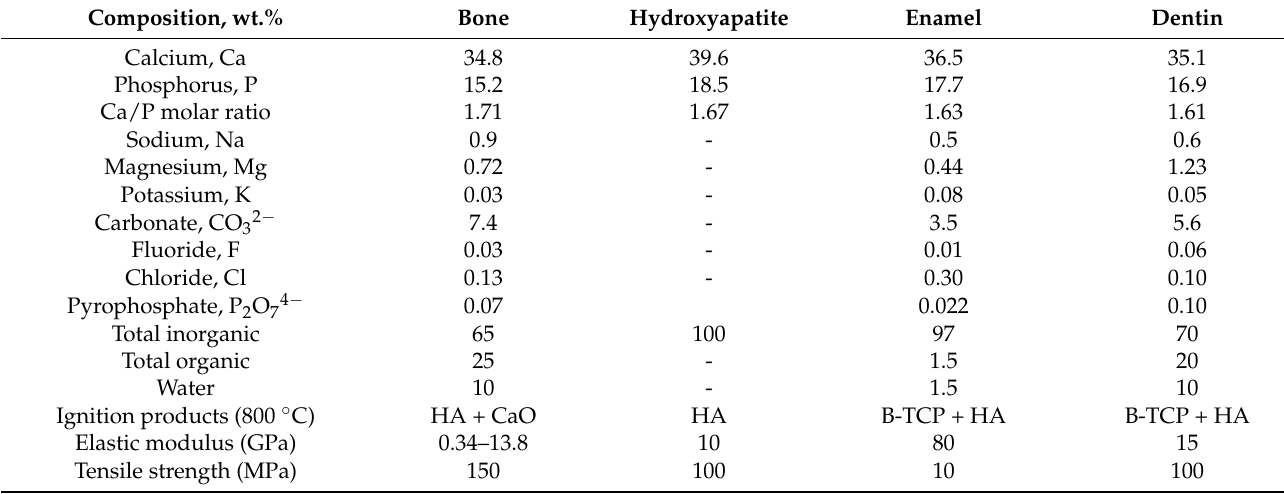
Figure 2. Classification of natural and synthetic biomaterials. Table 1. Comparison of the structure and structural parameters of adult human calcified tissues’ inorganic phases [31,32]. Composition, wt.%